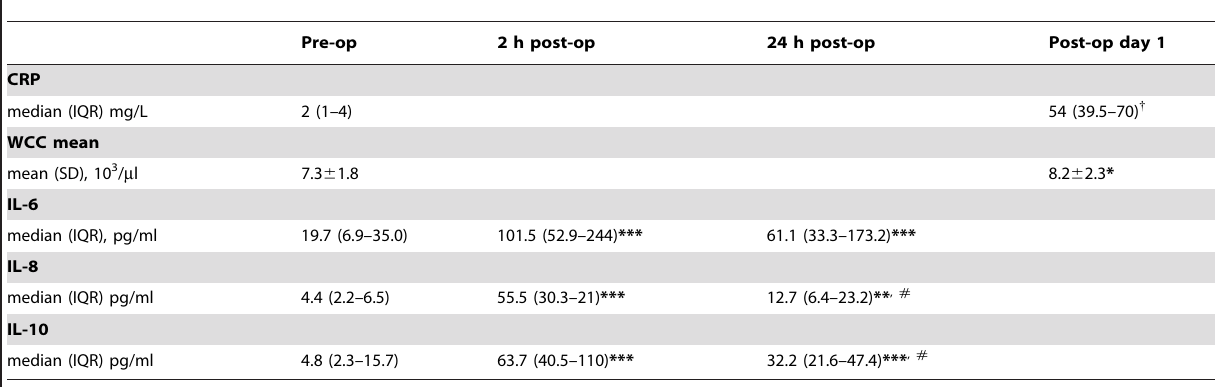
Table 2. Indices of systemic inflammation a